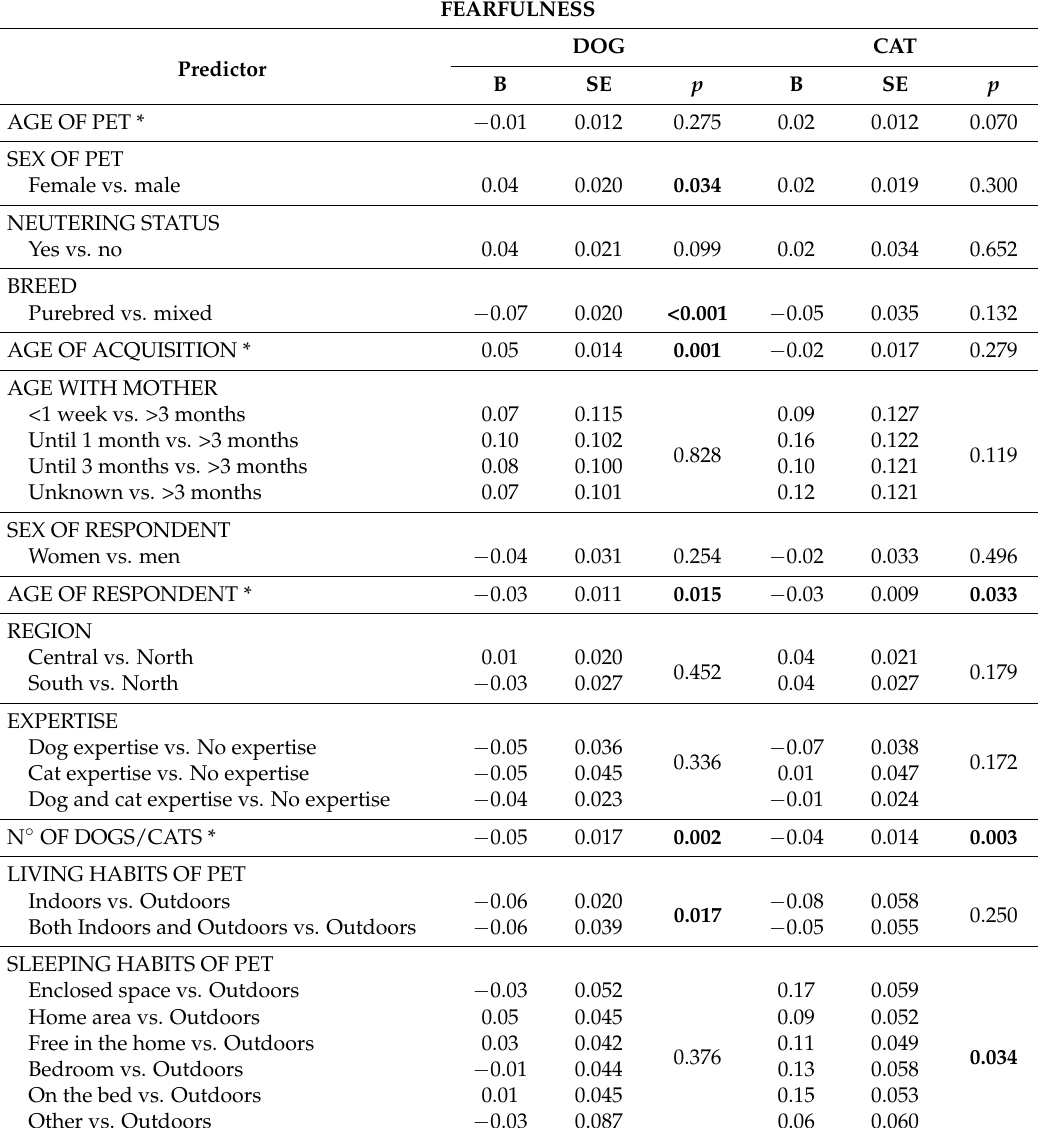
Table 6. Multivariate regression analysis for fearfulness in dogs and cats living in the same